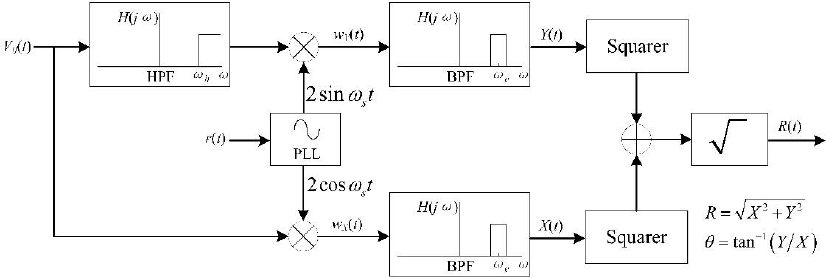
Figure 6. Block diagram of the high-pass-orthogonal-correlation-band-pass detection method.